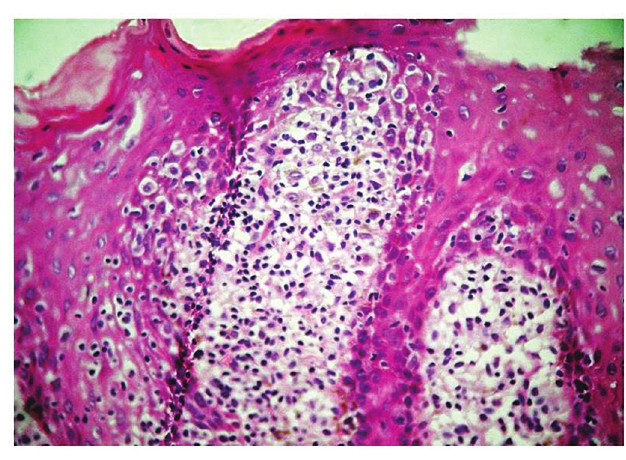
figurE 2 − Intraoral manifestations of LHS A) and B) dark diffuse bilateral macules in buccal mucosa; C) dark macules in palate. LHS: Laugier-Hunziker syndrome.